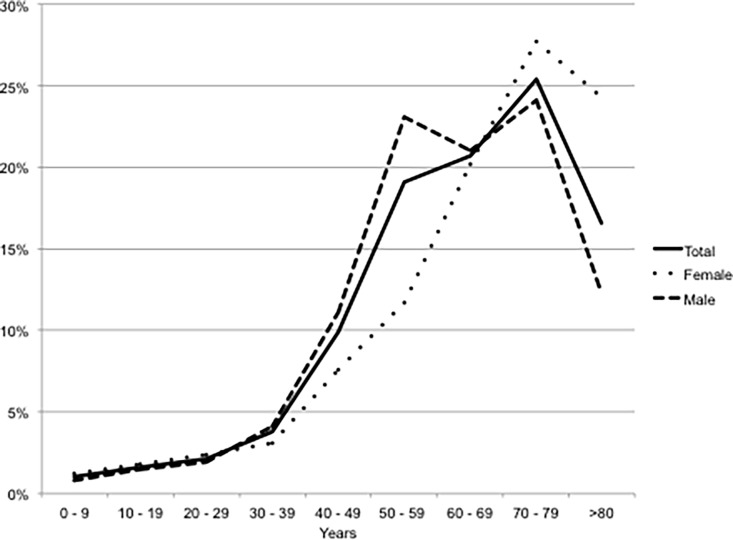
Gender-stratified age distribution of the HCM cohort.